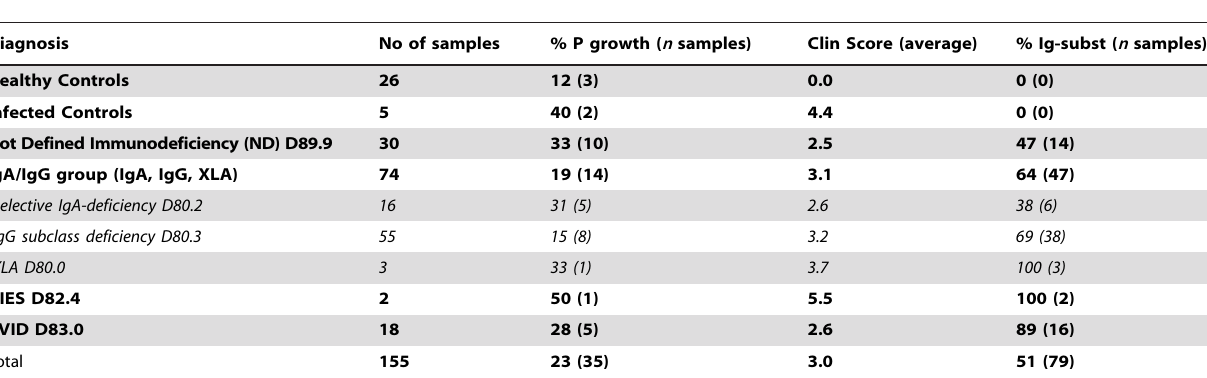
Table 1. Clinical characteristics of patients and